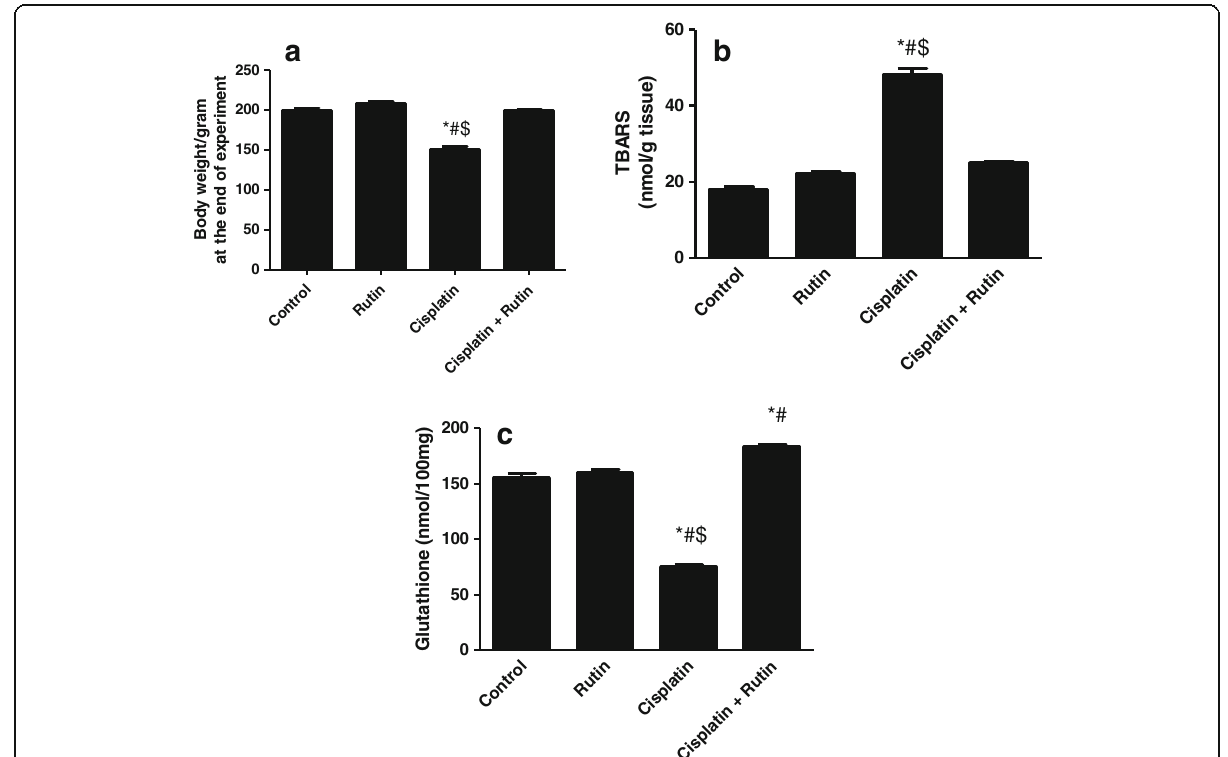
Fig. 1 The Effect of Cisplatin, rutin, and their combination on the body weight ( a ), TBARs levels ( b ) and glutathione ( c ). Data were presented as mean ± SEM ( n = 10). *, # and $ indicate significant change from control, rutin and CP + rutin, respectively, at P < 0.05 using ANOVA followed